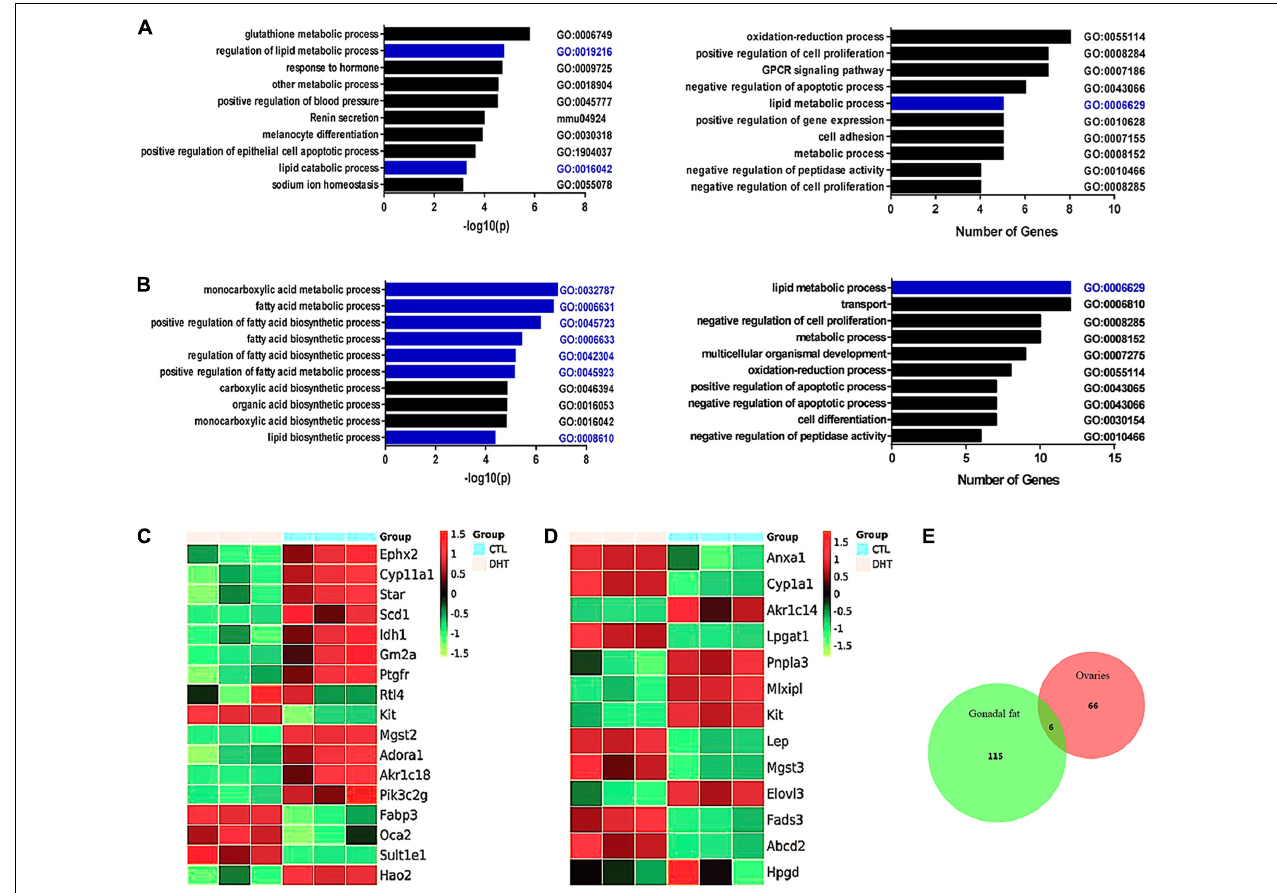
FIGURE 2 | Gene expression analysis of ovaries and gonadal fats from ctrl and DHT treated mice. (A) Gene ontology (GO) term enrichment analysis of altered mRNAs in ovaries. Left panel show the top 10 biology processes based on the statistical significant for altered mRNAs. Right panel show the top 10 biology processes based on the amount of altered mRNAs; n = 3. (B) Gene ontology (GO) term enrichment analysis of altered mRNAs in gonadal adipose tissues. Left panel show the top 10 biology processes based on the statistical significant for altered mRNAs. Right panel show the top 10 biology processes based on the amount of altered mRNAs; n = 3. (C) Altered mRNAs associated with lipid metabolic processes in ovaries (Up-regulated, red, Down-regulated, green, n = 3). (D) Altered mRNAs associated with lipid metabolic processes in gonadal adipose tissues (Up-regulated, red, Down-regulated, green, n = 3). (E) Venn diagram shows the aggregation relationship between ovaries and adipose tissues with abnormal expression of genes affected by DHT. Overlapping region include Col6a5 ; n =